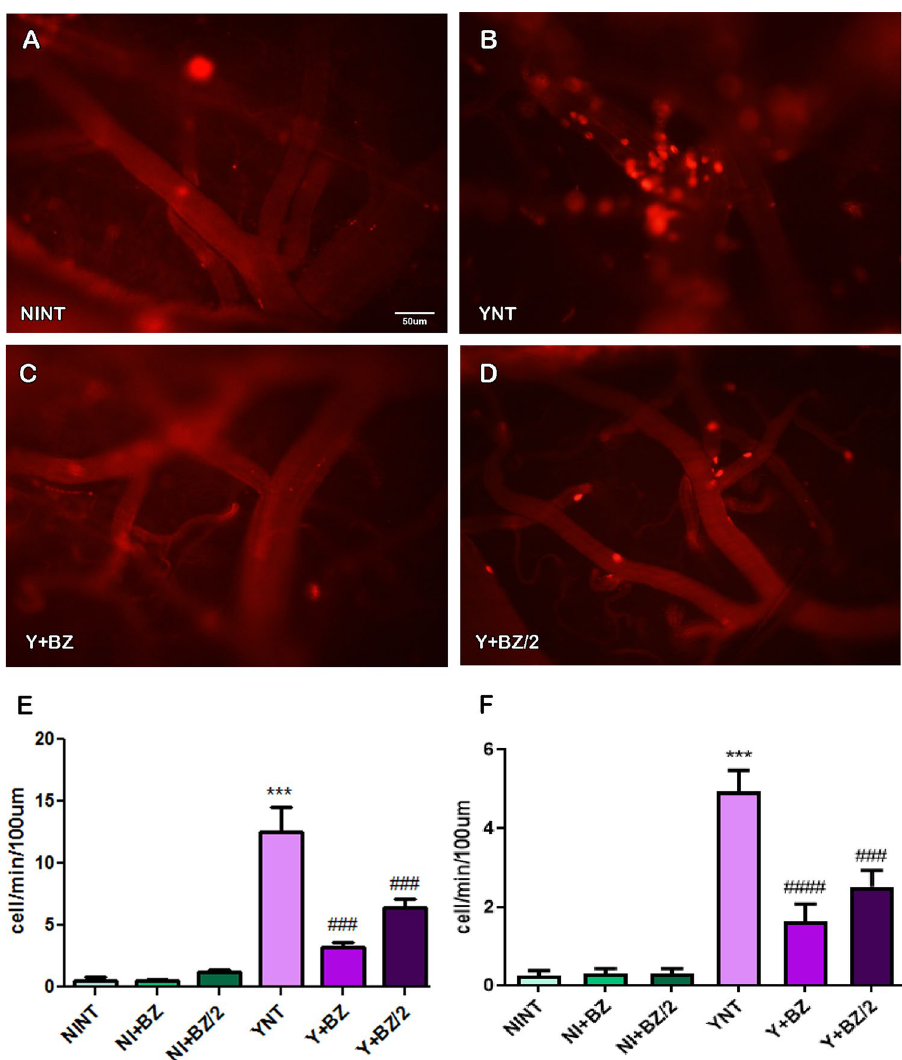
Figure 3. Analysis of leukocyte-endothelium interaction by intravital microscopy in mouse brain at 15 dpi. Increased number of leukocytes rolling and adhering to venules were observed in the YNT group ( B ) when compared to the NINT group ( A ). BZ treatment prevented both rolling and adhesion ( C ), and BZ/2 treatment only prevented the rolling of leukocytes ( D ). The graphic indicates the number of leukocytes rolling ( E ) and adherent ( F ) to venules. NI, nom infected; Y, infected; NT, non treated; BZ, treated with benznidazole (100 mg/ kg/day); BZ/2, treated with benznidazole (50 mg/kg/day); dpi, days post-infection. *when compared to NINT; #when compares to YNT; *p < 0.05, **p < 0.01, ***p < 0.001, ****p <